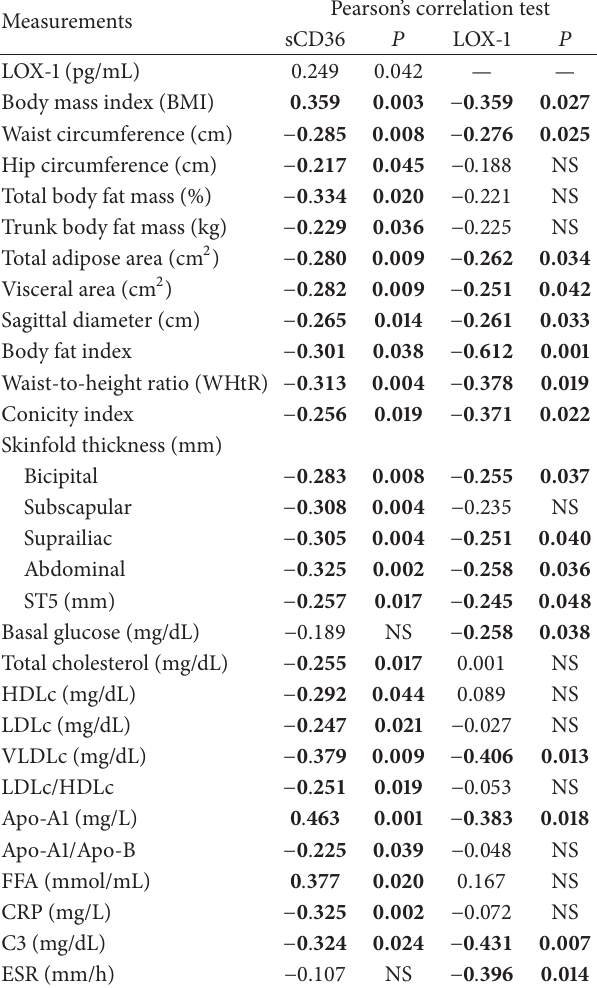
Table 3: Correlation of adiposity with scavenger receptors markers and systemic low-grade inflammatory state along body fat